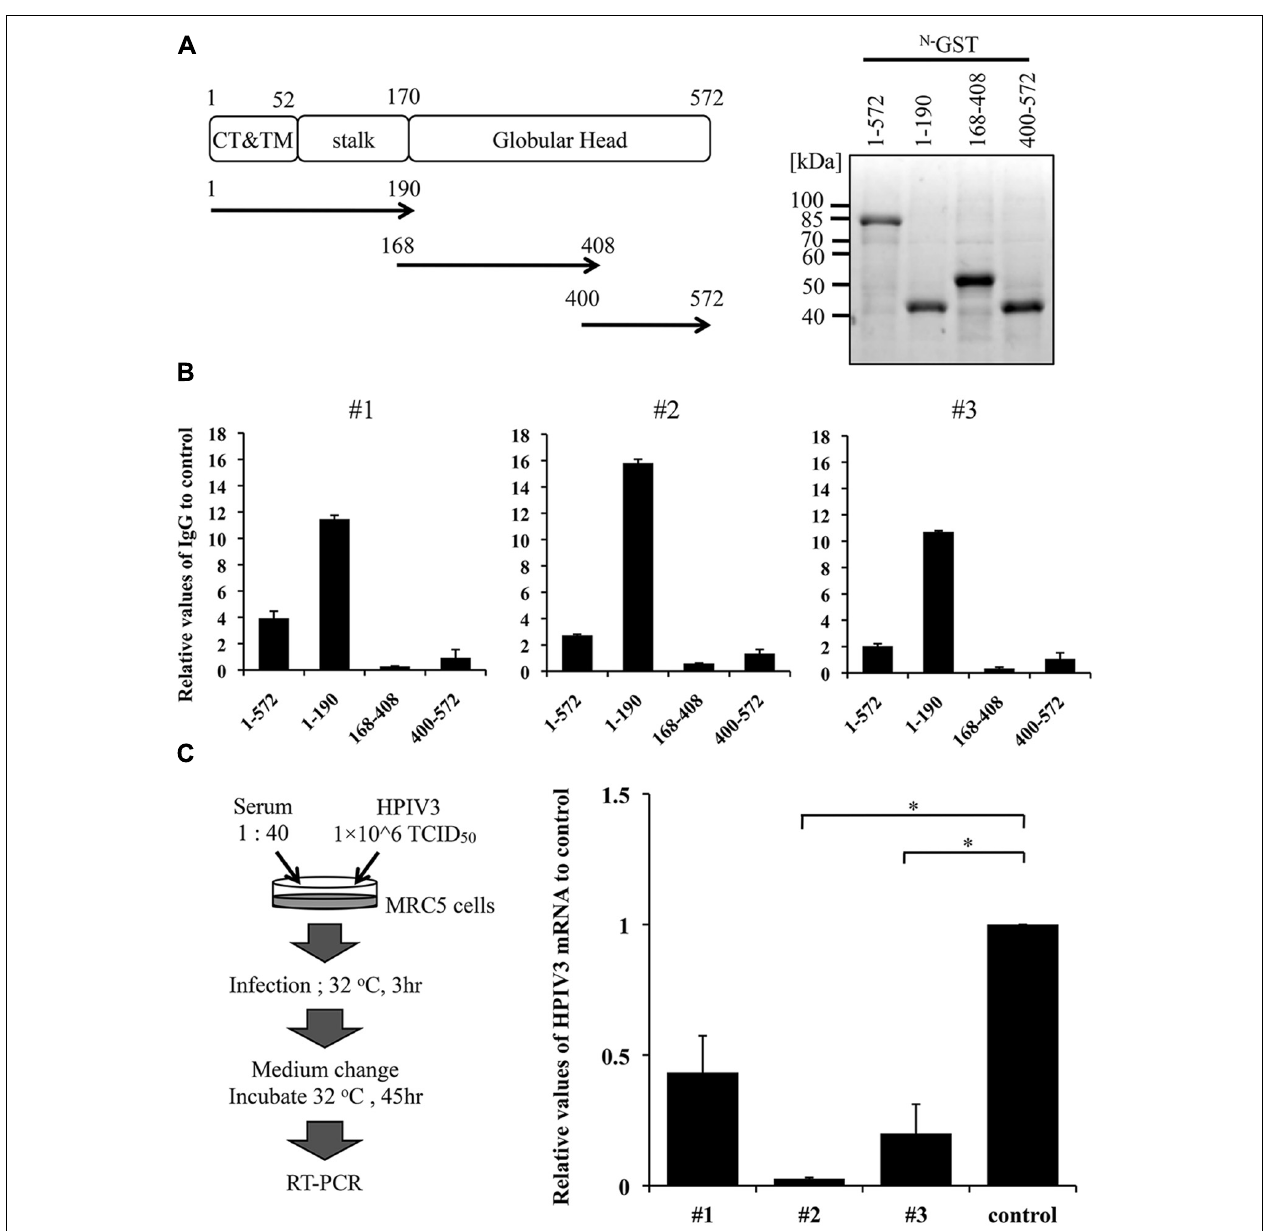
proteins, the target region of the three sera (#1–#3) was analyzed by ELISA (B) . (C) Schematic representation of the experimental procedure of infection-inhibitory assay (left panel). Immunized mouse sera (#1–#3) were tested for this assay. An OML-empty-treated mouse serum was used as a control.The anti-infection ability was measured using quantitative real-time PCR for HPIV3-HN mRNA. Each bar represents the mean ± SE of two independent experiments as normalized by control serum ( t test: * P <